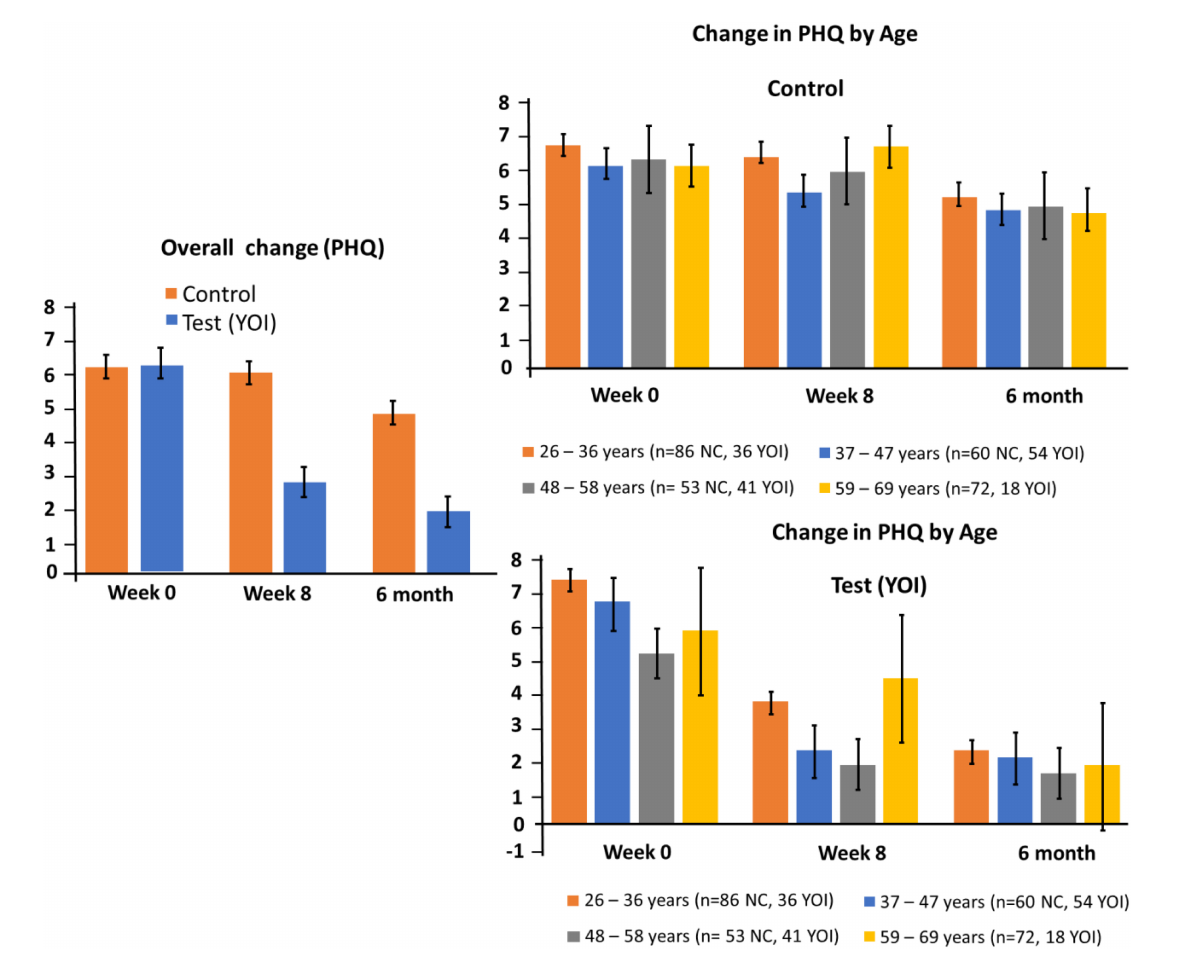
FIGURE4 Changes in PHQ-8 at week 0 and Week 8. Left panel: overall change for controls and participants. Right panel: subgroup changes by